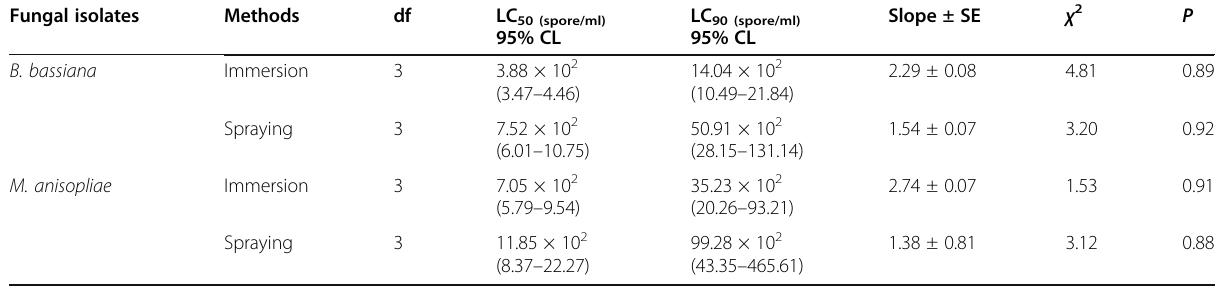
Table 1 Estimated lethal concentrations for Beauveria bassiana and Metarhizium anisopliae on 1st instar larvae of Xanthogaleruca luteola using immersion and spraying methods Fungal isolates